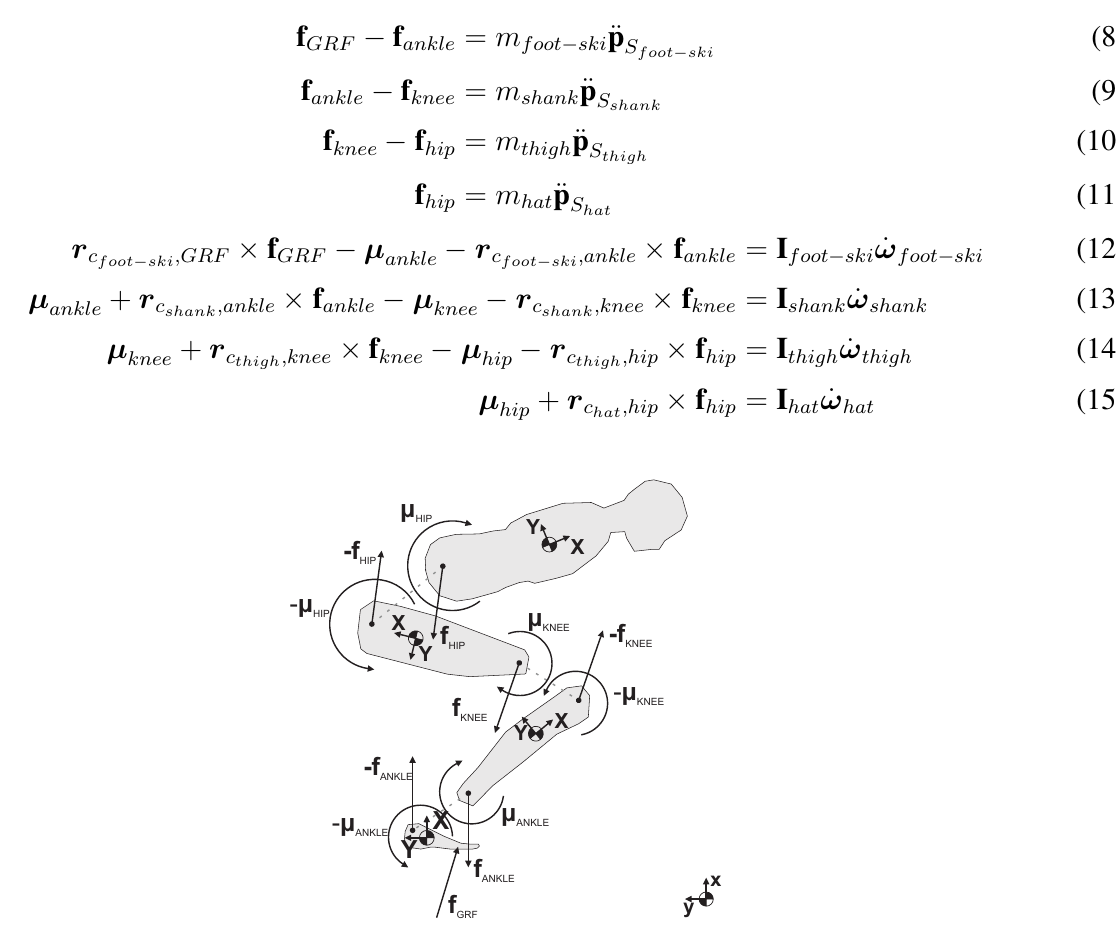
Figure 3. Recursive Newton–Euler inverse dynamics model of a ski jumper. The basic idea of the recursive approach is to first calculate variables for segment i , then calculate the unknown joint variables i + 1 and, in the next step, proceed with the calculation.